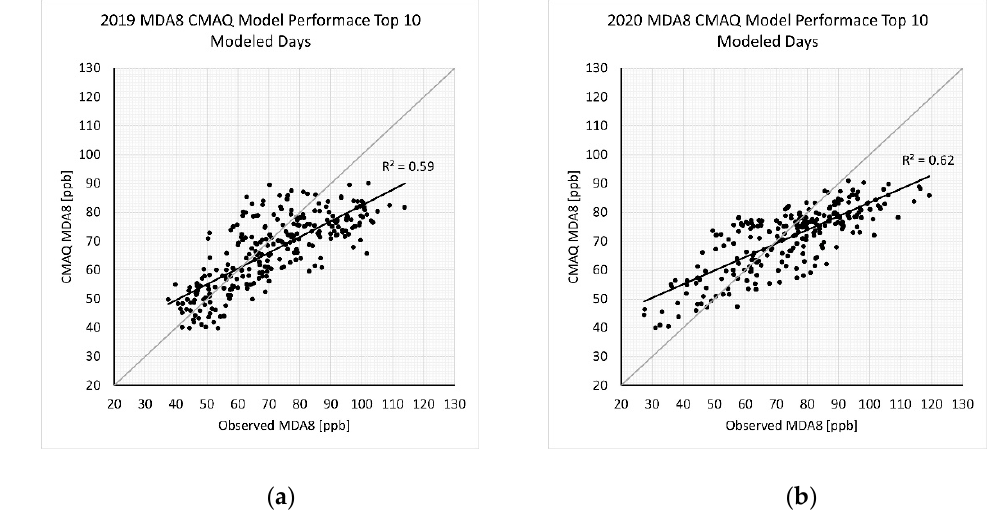
Figure 7. Model performance scatter plots of the T10 modeled days: ( a ) 2019 Base; ( b ) 2020 COVID. Table 2. NMB and NME for the T10 modeled days used in the RRF calculations 1 .